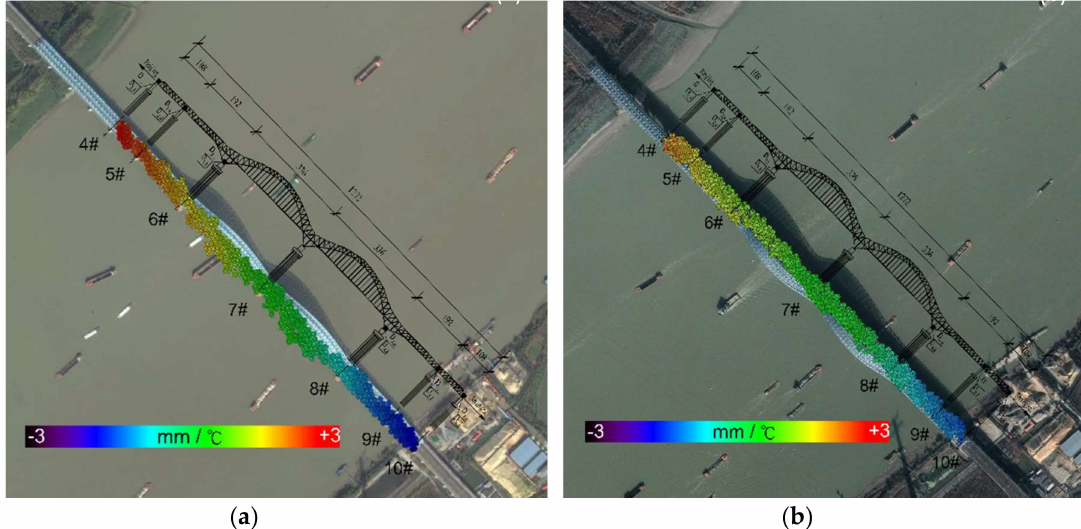
Figure 8. Estimated thermal dilation parameter in the LOS direction. The figure marked with ‘( a )’ is related to Track 01, and that marked with ‘( b )’ refers to Track